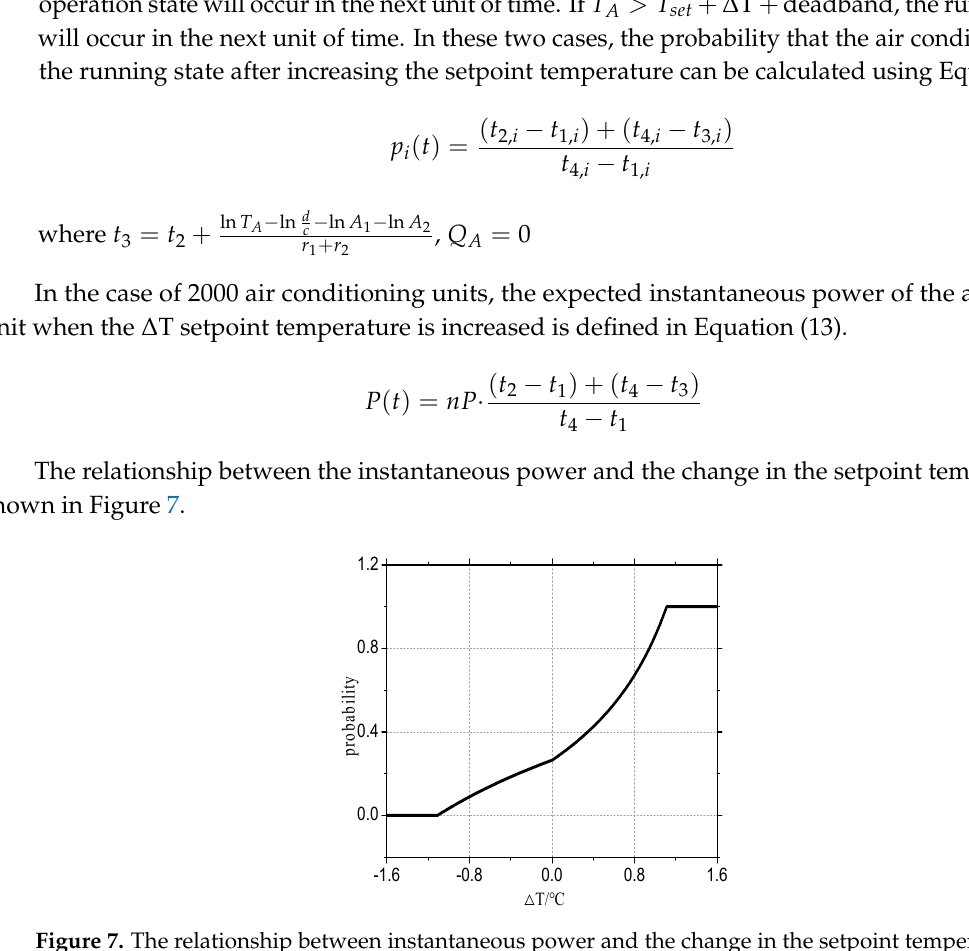
Figure 7. The relationship between instantaneous power and the change in the setpoint temperature.